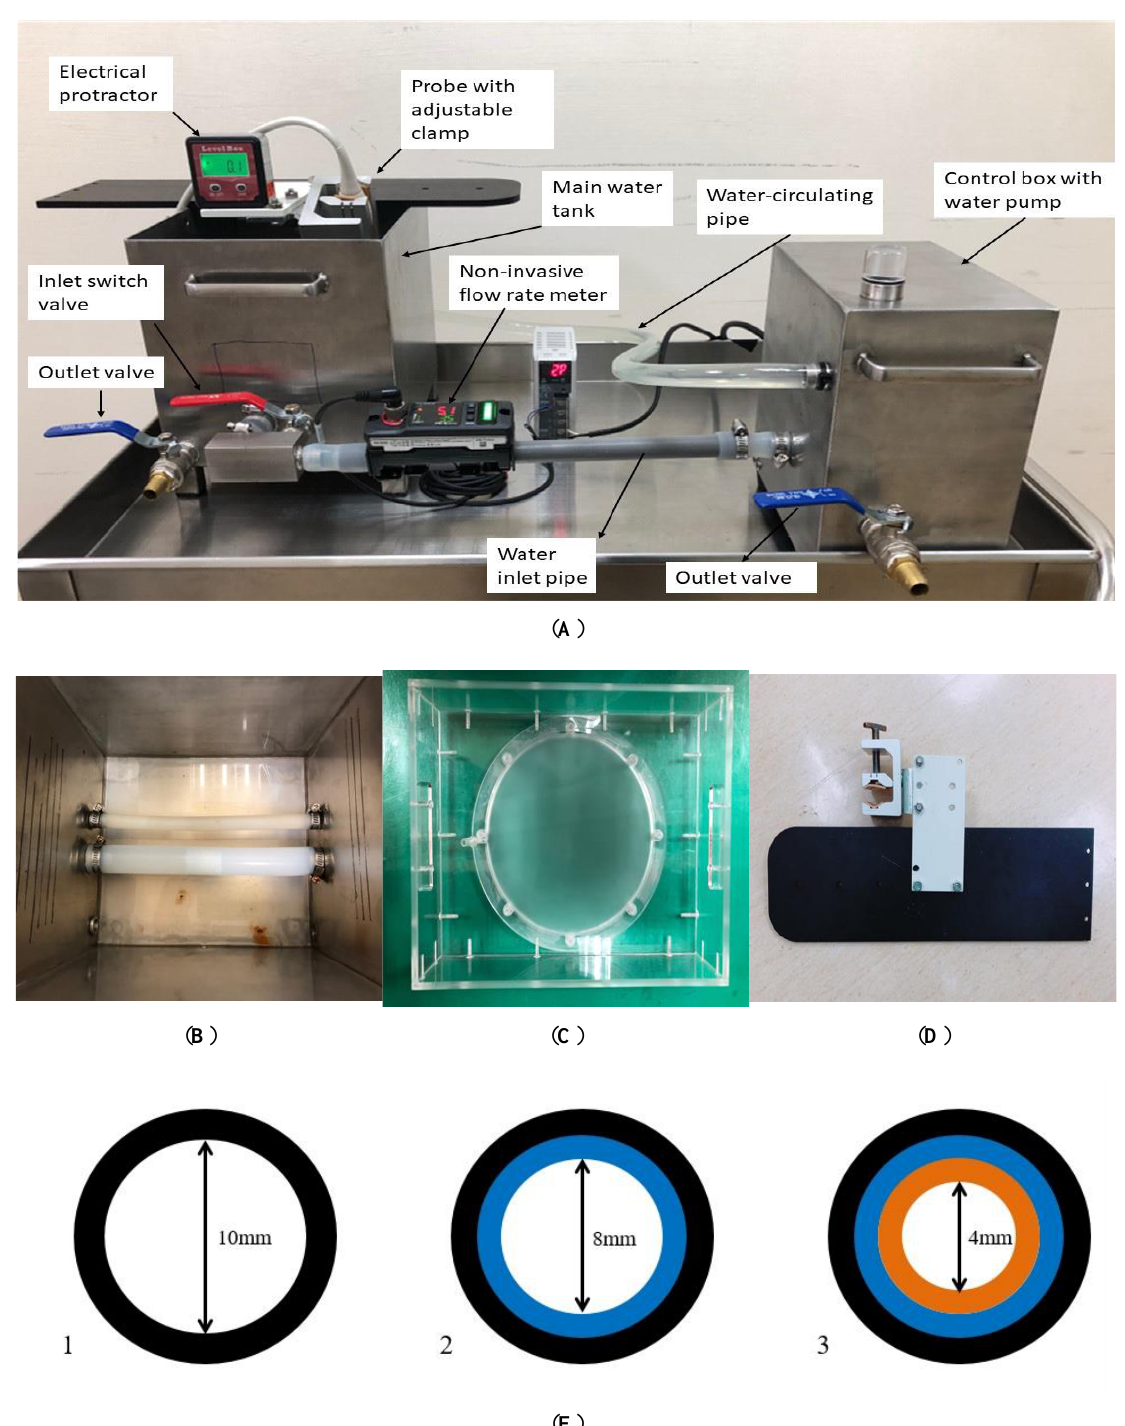
Figure 2. ( A ). The left part is the main water tank. The right part is the control box, whereas the central electronic device is a noninvasive flow rate meter. ( B ) The inner part of the water tank (L × W × H; 244 × 194 × 202 mm 3 ). It includes two silicon pipes with inner diameters of 19 and 10 mm, and the 10 mm pipe is the target in this study; ( C ) 2 mm-thick silicon film 175 mm in diameter, simulating human skin, which could be pressed tightly over the water surface; ( D ) a close-up view of the adjustable clamp, which provides the required probe for scanning; and ( E ) the illustration of artificial stenosis made by silicon pipes similar to the pipe adopted in this work.